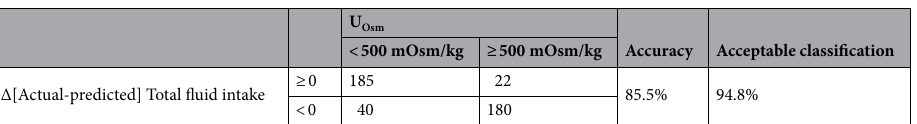
Table 3. Contingency table of the machine learning/optimization algorithm prediction of total fluid intake. Values are number of datapoints per category. Total sample size is n = 427 datapoints.